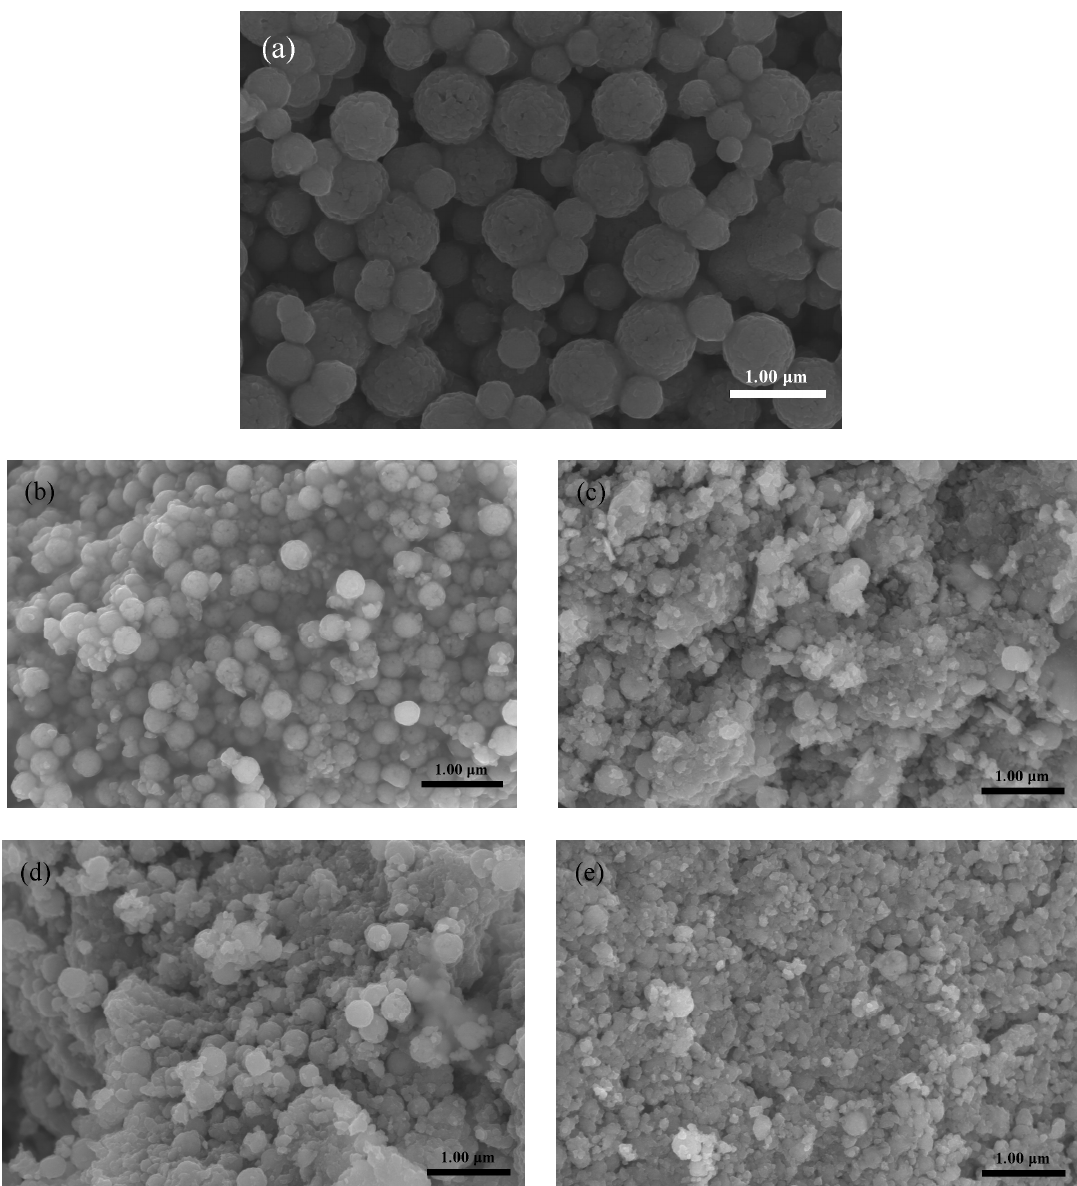
Figure 2. SEM images of Fe 3 O 4 samples at di ff erent ball-milling times. ( a ) Ball milling for 0 h; ( b ) Ball milling for 0.5 h; ( c ) Ball milling for 1.0 h; ( d ) Ball milling for 1.5 h; ( e ) Ball milling for 2.0